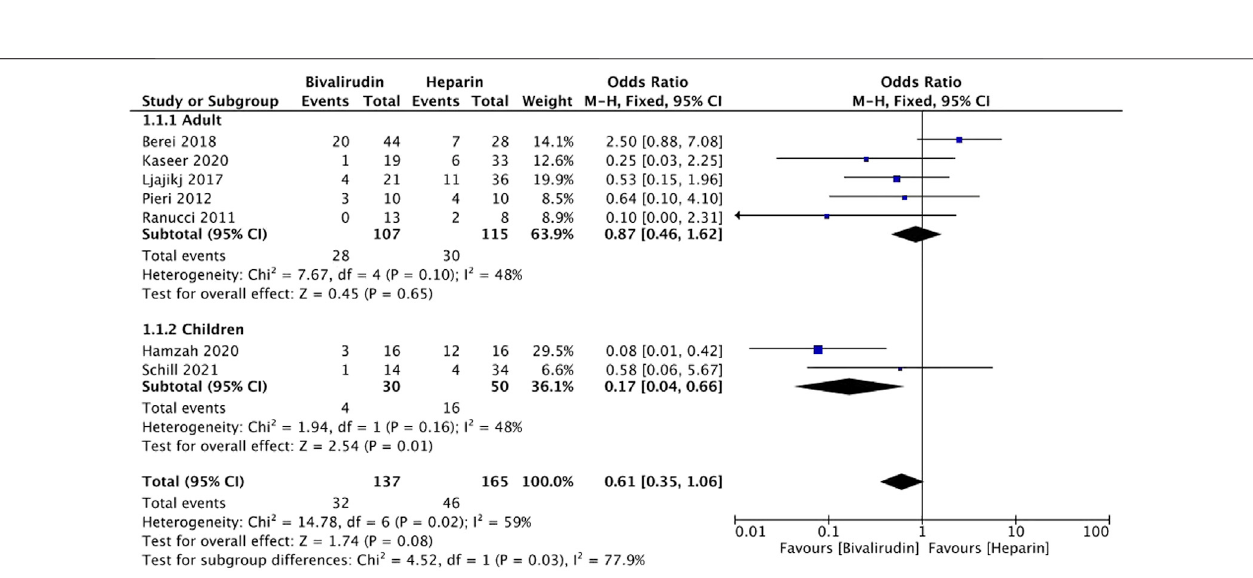
FIGURE 2 | The incidence of major bleeding between the bivalirudin group and the heparin group.